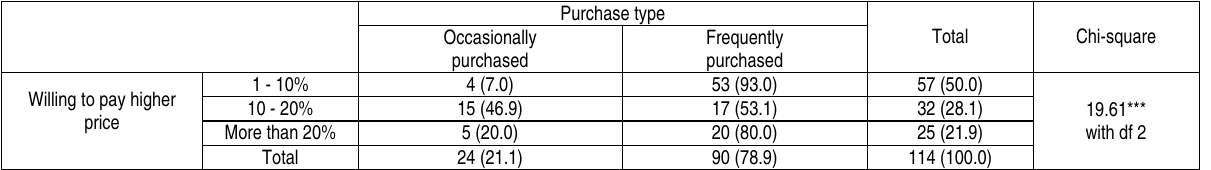
Table 4. Cross tabulation: relation between purchase type and willingness to pay higher price for green